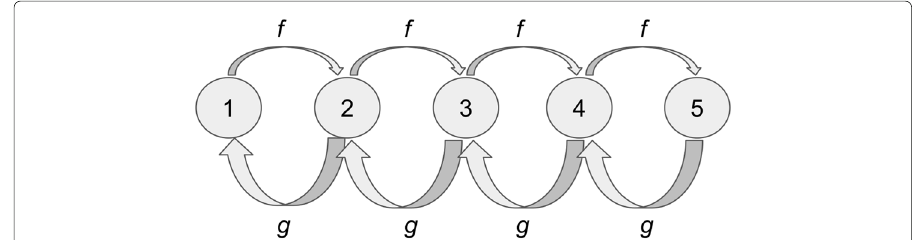
Fig. 8 Example network for illustrating DebtRank. This network has five nodes and is both weighted and directed. The quantities f and g denote the weights of the edges. We use arrow widths to highlight our assumption that g >